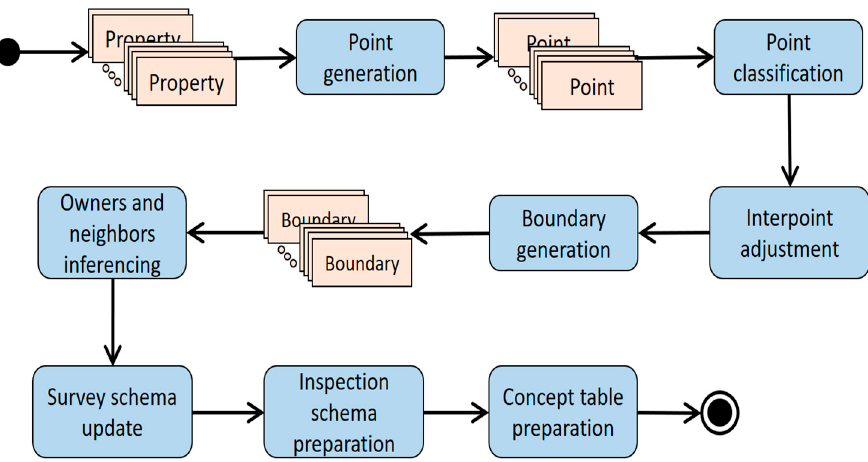
Figure 8. Activity diagram for post-processing stage.